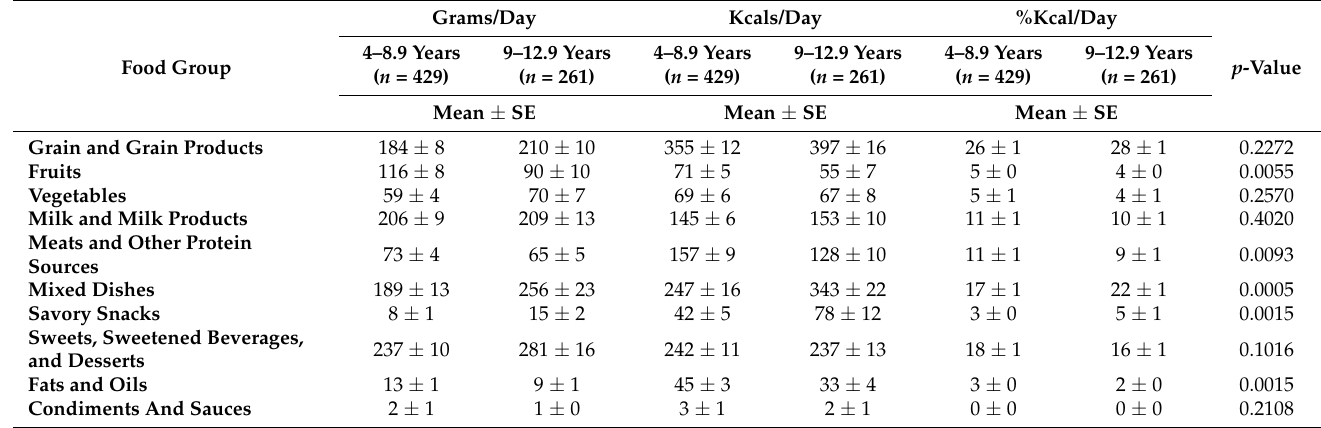
Table 2. Mean intake of various food groups among UAE children aged 4 to 12.9 years per capita separated by age, KNHS